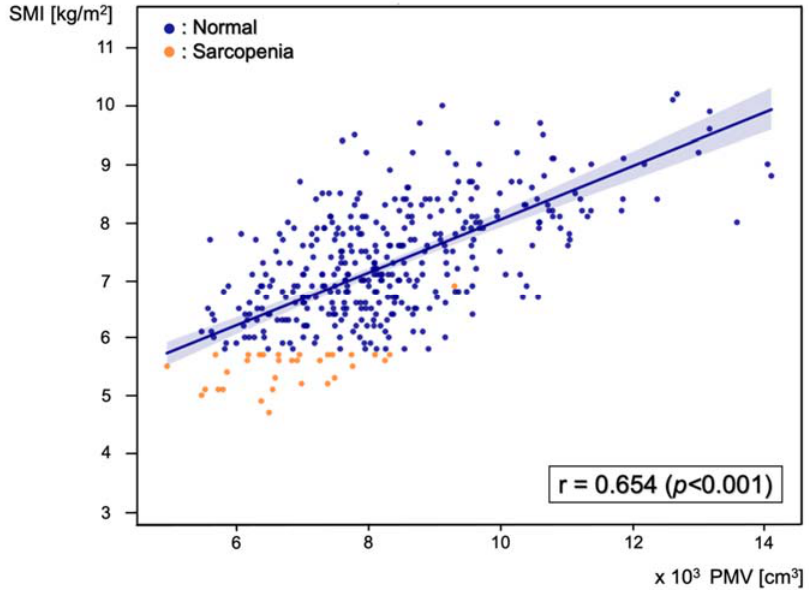
Figure 3. Scatter plot of the correlation between predicted muscle volume (PMV) and skeletal muscle index (SMI), with a Pearson’s correlation coefficient of 0.654 ( p < 0.001). Blue dots represent patients in the normal group and orange dots represent patients in the sarcopenia group.